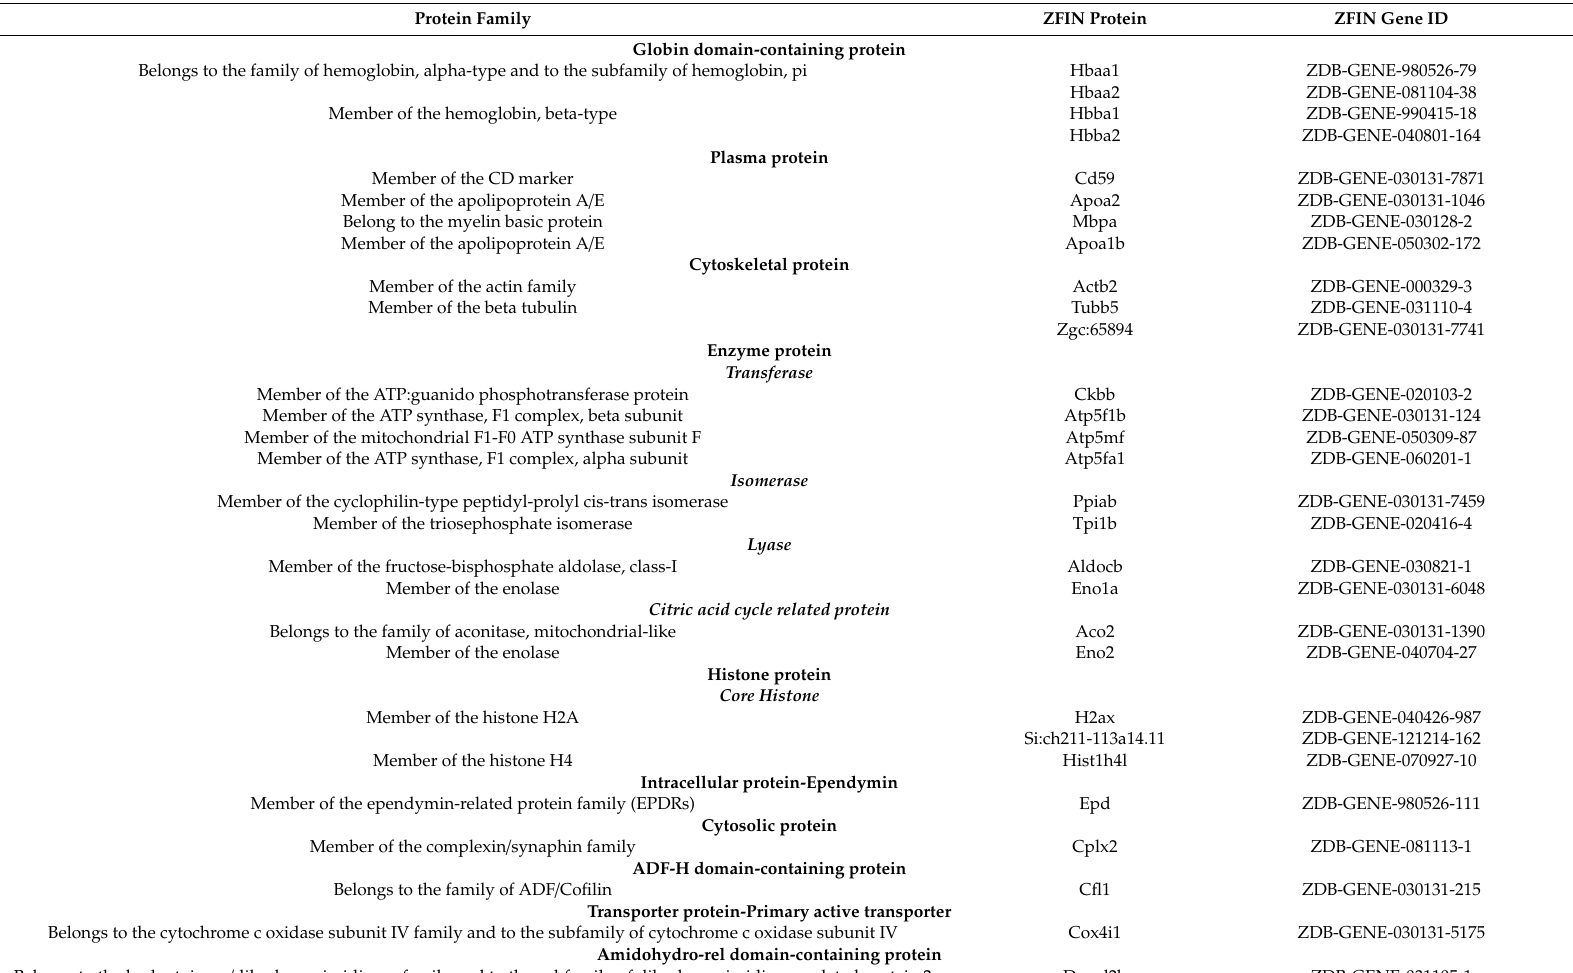
Table 5. Protein family of the di ff erentially expressed proteins identified from negative control (NC, PTZ 170 mg / kg only) and O + P (OSLP 800 µ g / kg + PTZ 170 mg / kg) zebrafish